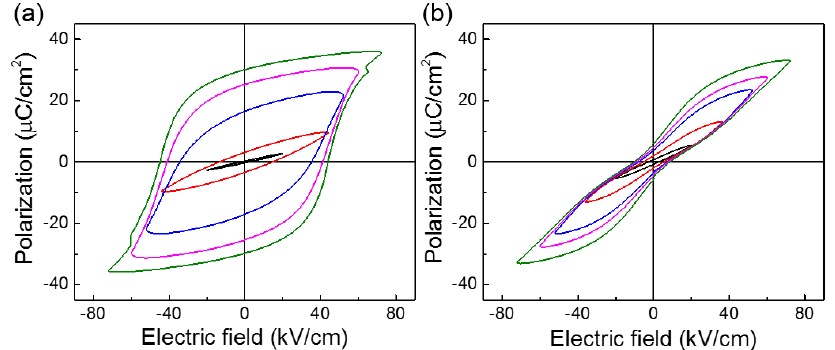
Figure 8. Polarization–electric field ( P - E ) hysteresis loops of for ( a ) x = 0.05 and ( b ) 0.10 at different E - E field.